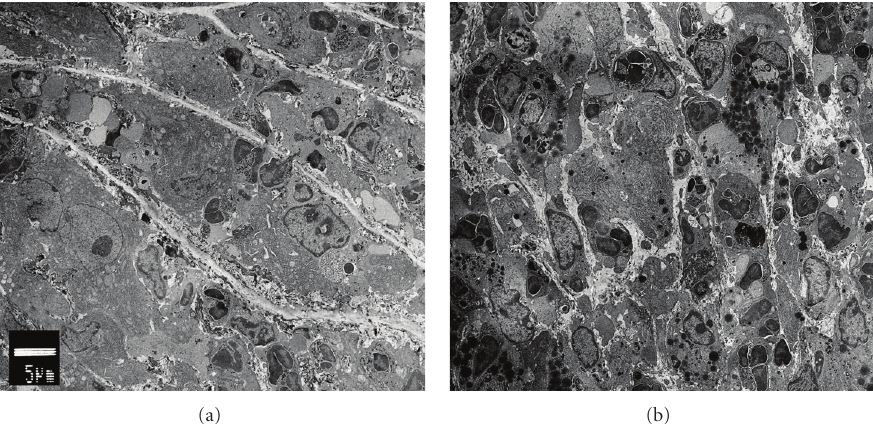
Figure 3: The tissue image of the CAWS arteritis by electron microscope. The images demonstrated direct invasion to the elastic fiber (a) and the activated inflammatory cells accumulation in the abscess-like lesion